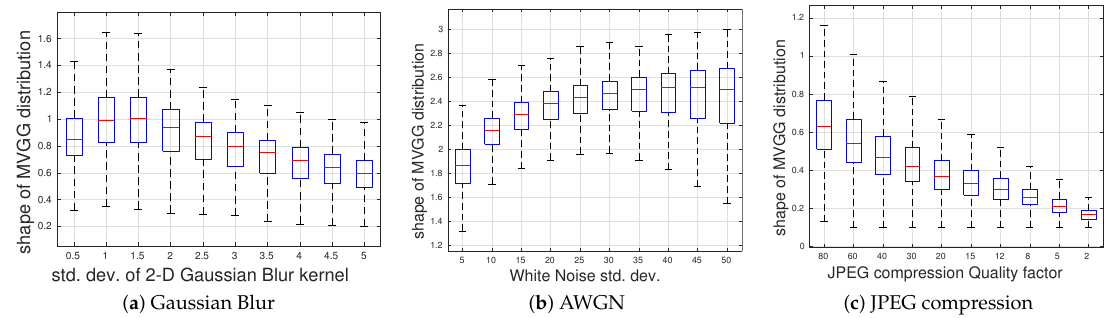
Figure 5. Boxplots of the estimated shape parameter s for three different distortions: ( a ) Gaussian blur, ( b ) AWGN and ( c ) JPEG compression (MATLAB’s imwrite function is used to control the degree of JPEG compression by specifying ‘quality’ as the argument in the imwrite function). Outliers were removed from the plots for better